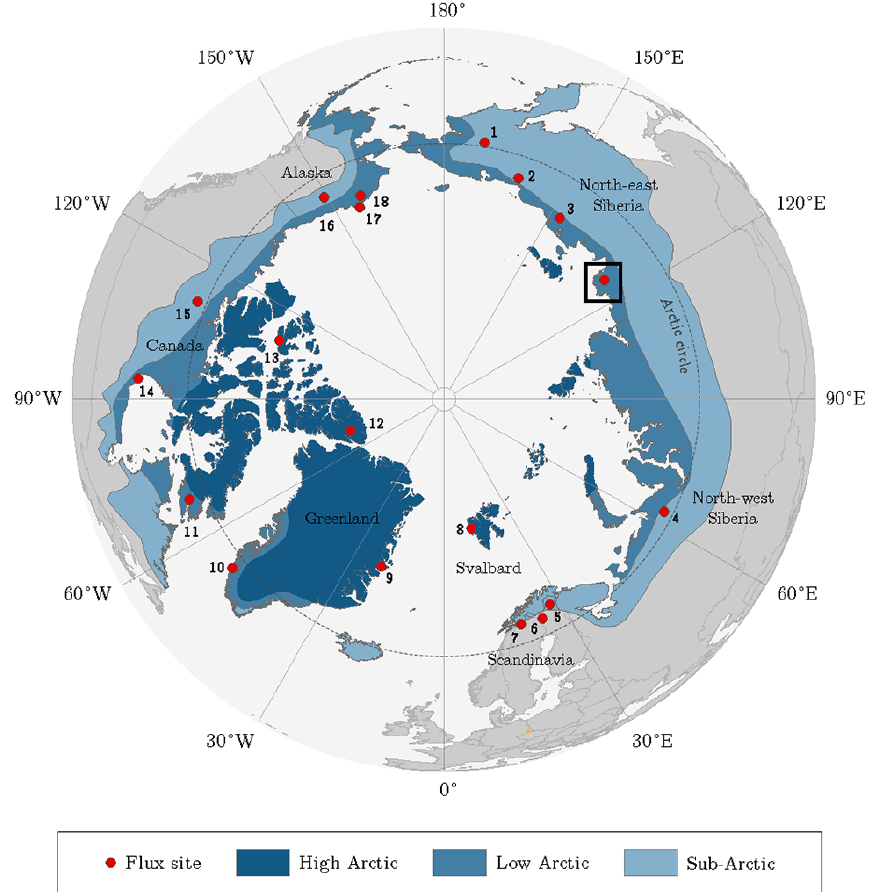
Figure 1. Location of the Lena River Delta in northern Siberia indicated by the square. The dots point out sites that were utilised for the pan- Arctic comparison of carbon dioxide budgets (Table 3). The classification of the Arctic zones was based on vegetation occurrence (modified from AMAP, 1998). Accordingly, the treeline delimits the (terrestrial) Arctic; i.e. it corresponds with the boundary between sub-Arctic and low